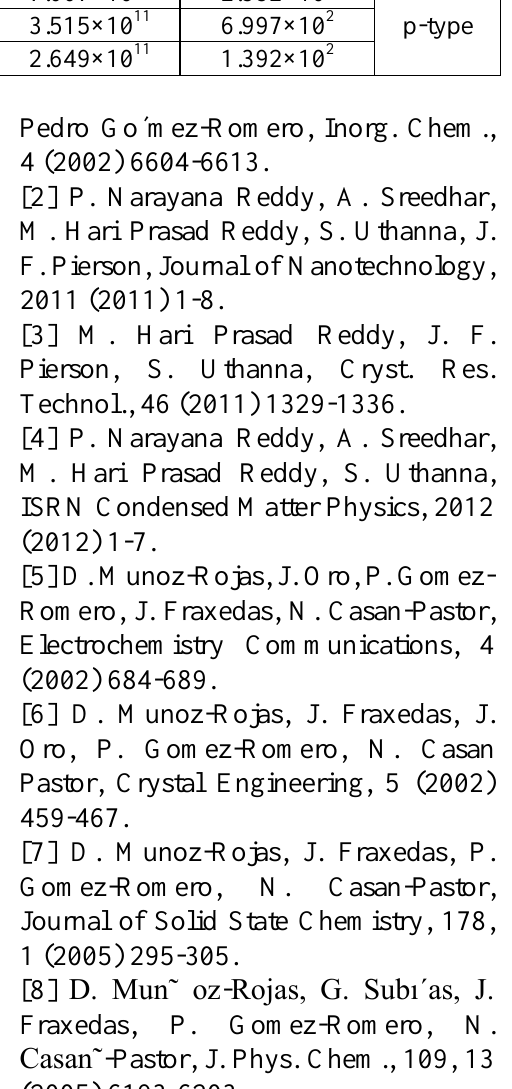
Table 10: Hall Effect measurements for Ag annealing at 200 °C for half an hour with different sintering temperature. Thin